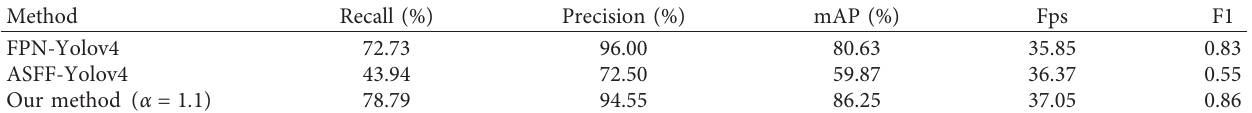
Table 4: Results of different fusion modules in Yolov4.